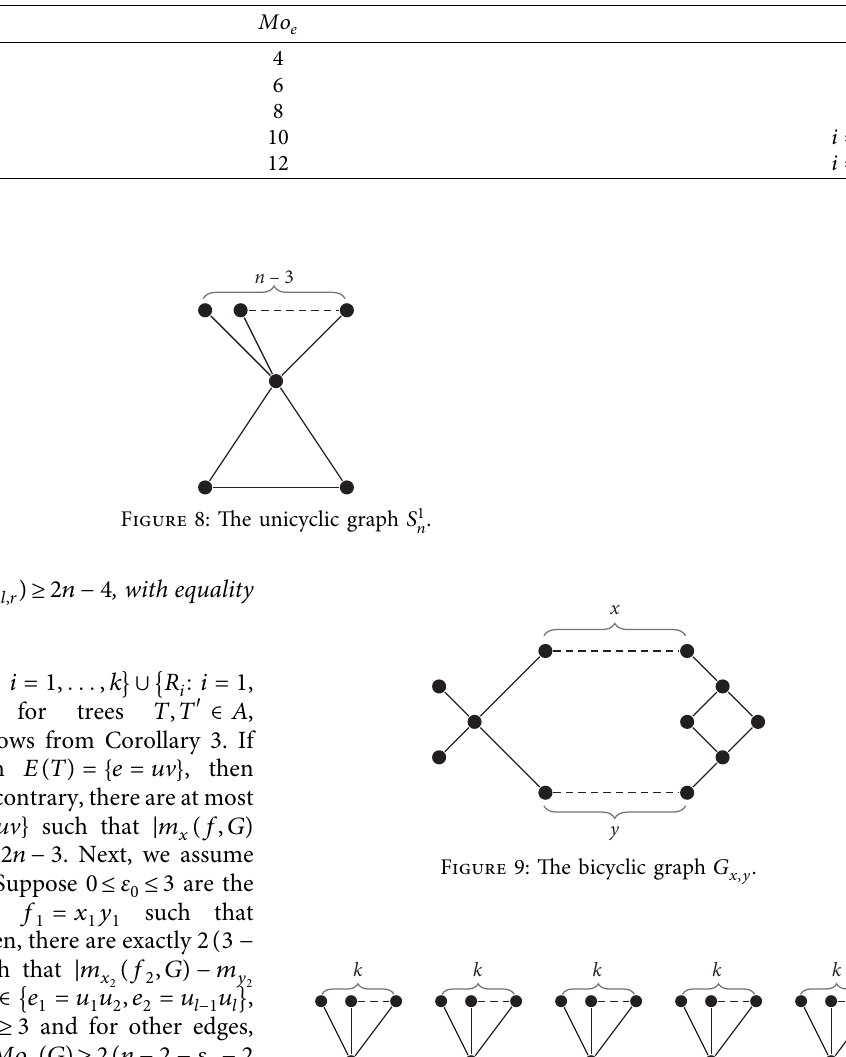
. (b) G . (c) G . (d) G 1 . (e) G 2 . (f) G 1 . (g) G 2 4 5 6 7 7 8 8